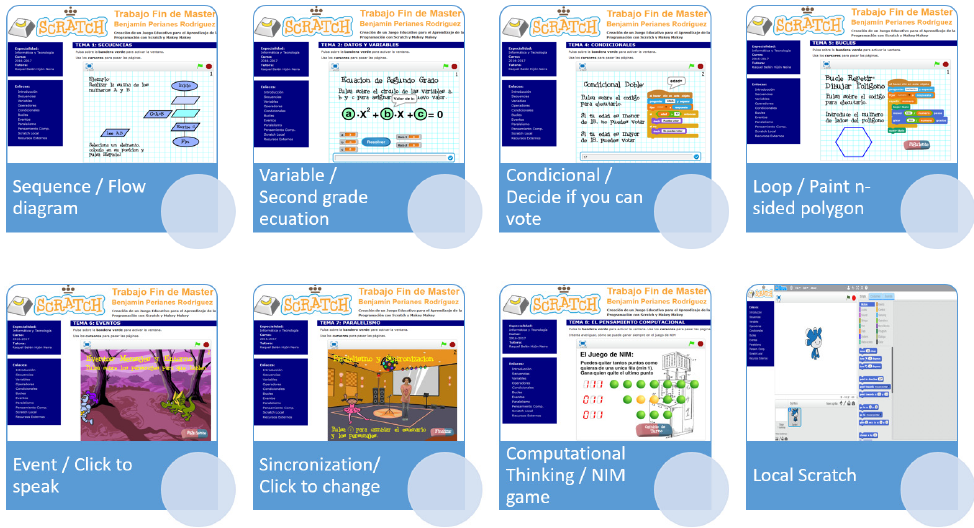
Figure 3. The TPACK Guided Scratch VEE with the programming concepts and some of their Scratch programs. Last option is Local Scratch.